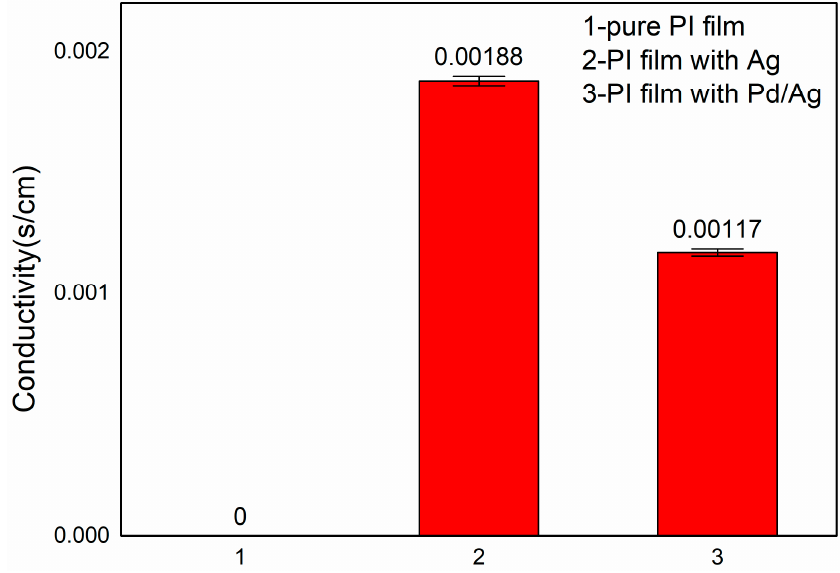
Figure 8. Electrical conductivity of the various films as measured by a four-probe resistivity tester.